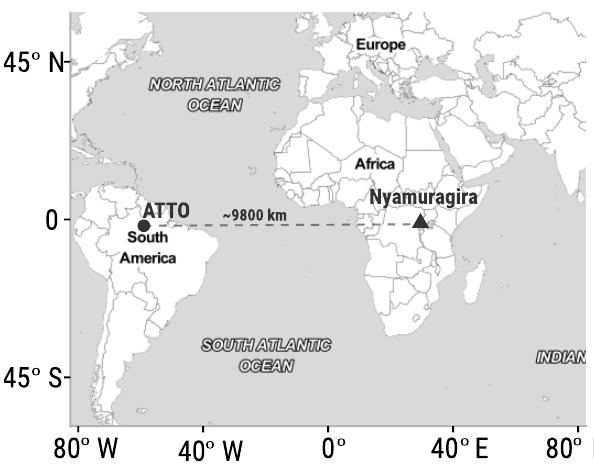
Figure 1. ATTO site and Nyamuragira volcano